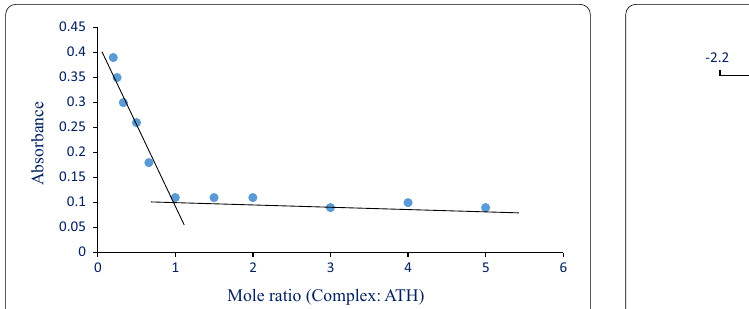
Fig. 3 Plot of log k ob versus log[ATH] for the reaction of [Mo IV O 2 (paoH) 2 ] 2 − and ATH at [Mo IV O 2 (paoH) 22 − ] 1.5 10 − 3 mol dm − 3 , µ = × D 77.9, [ATH] (1.5—15.0) 10 − 2 mol dm − 3 , λ max = = × T 300 =